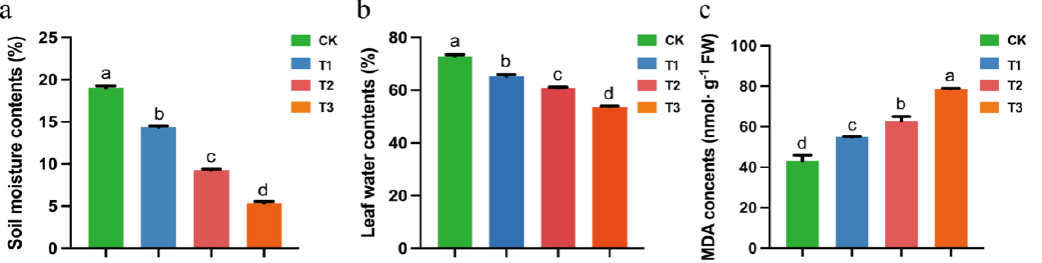
Figure 7. ( a ) Soil water content in different drought degrees. ( b ) Leaf water content of tea plant in different drought degrees. ( c ) MDA content of tea plant in different drought degrees. Data were the mean of three independent replicates ± standard deviation (SD). Different lowercase letters indicate significant differences at different drought degrees ( p < 0.05).